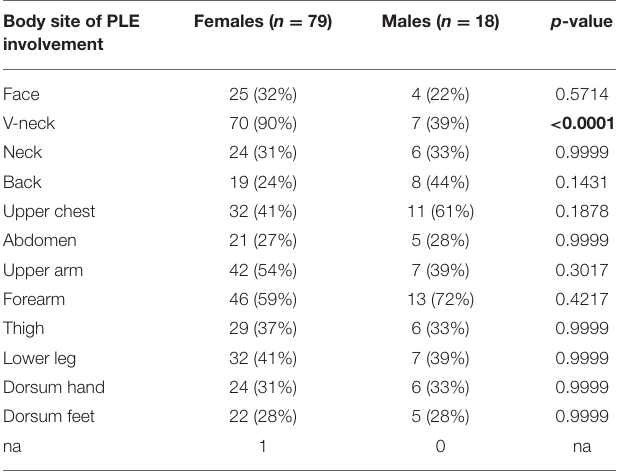
TABLE 2 | Body site involvement in PLE.